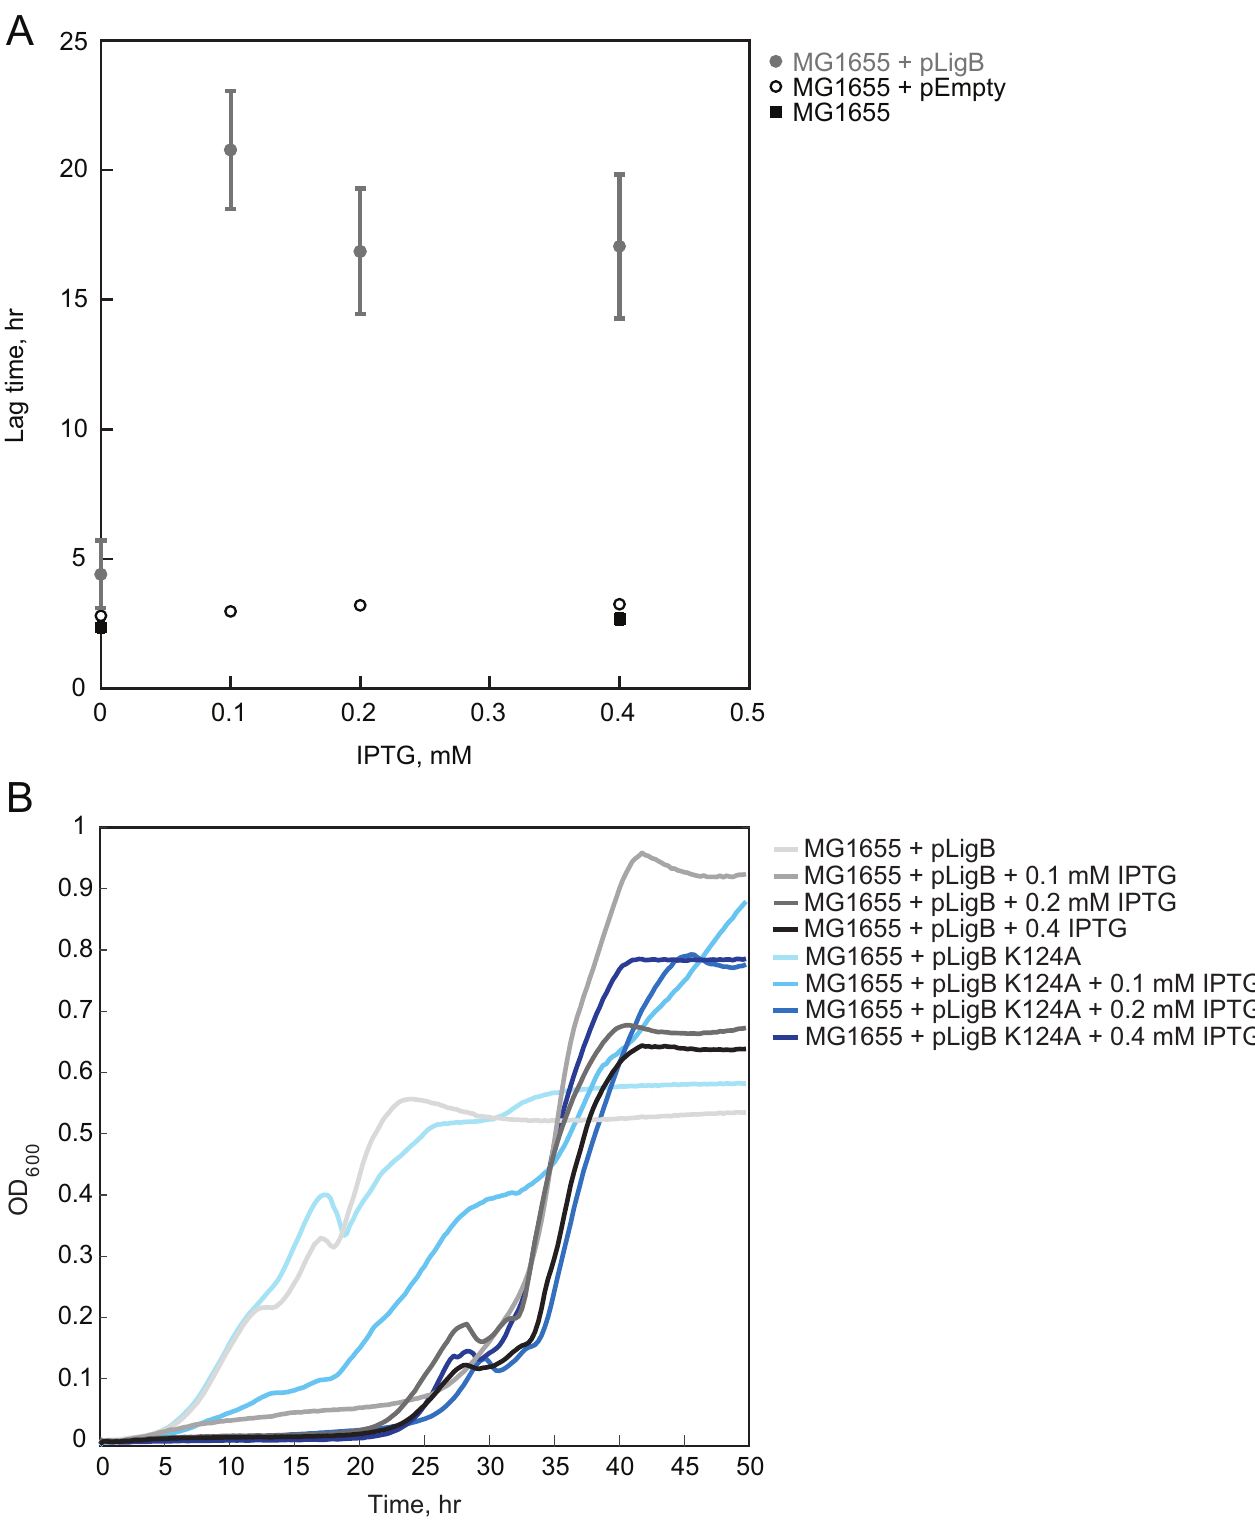
Fig 3. Effect of lig B overexpression on E . coli growth. (A) E . coli MG1655 either without ( ■ ) or with ( ● ) plasmidpCA24NJW3622 [48] (pLigB), which encodes ligB under control of the T5 lac promoter, were grown in the absenceor presenceof IPTG. As a negative control, E . coli